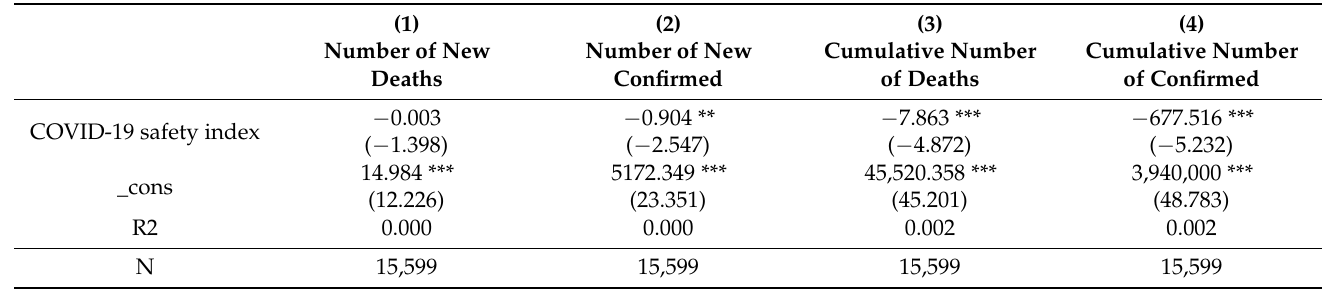
Table 8. Correlation analysis between the COVID-19 safety index and the actual performance index of the epidemic in 150 countries.